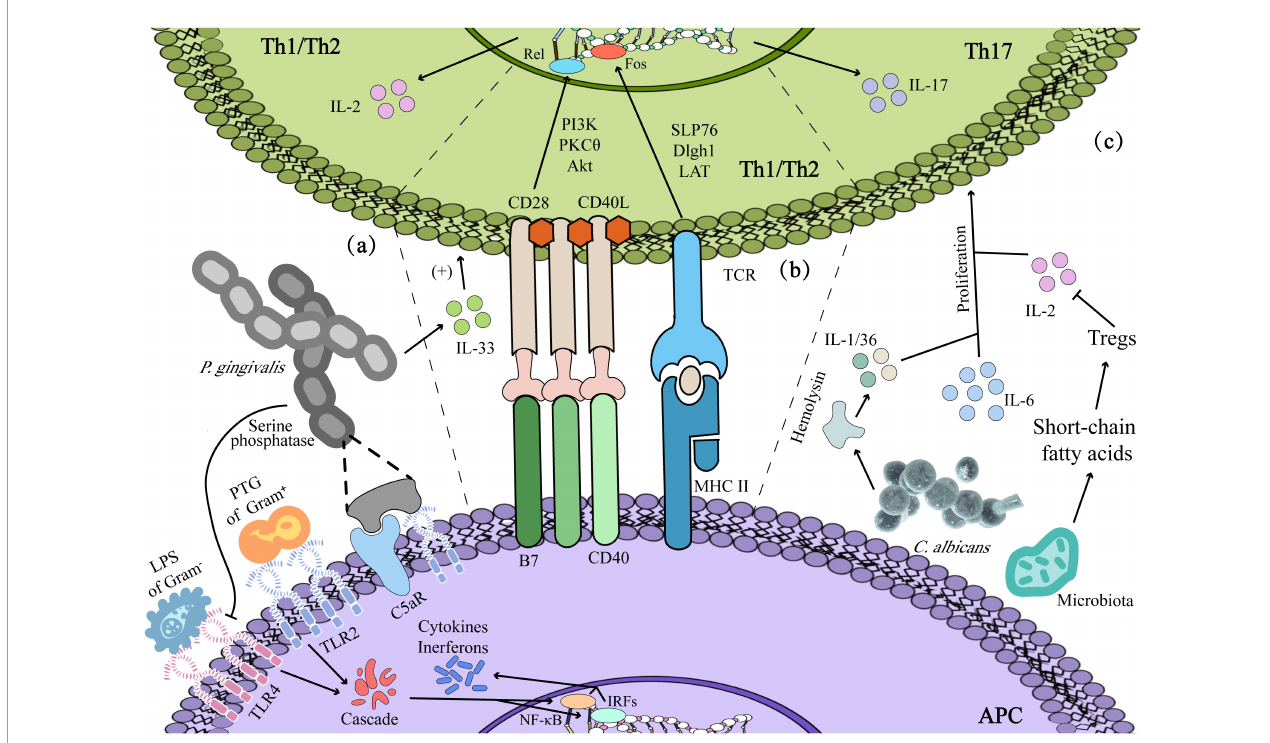
FIGURE3 Dysbiosis-induced immunoreaction: (a) innate immunity: lipopolysaccharide (LPS) and Peptidoglycan (PTG) contribute to the activation of immune and inflammatory responses in Th1/2. (b) Adaptive immunity: Porphyromonas gingivalis enhanced Th2 cytokine-mediated inflammatory immune response by prompting the secretion of IL-33 of epithelium, and antigen presentation by antigen–presenting cells (APCs) could activate Th1/2 by signal 1 and signal 2. (c) Candida albicans producing cytokines such as IL-1/IL-36 mediates the expression of IL-17 and the proliferation of Th17 cells, and short-chain fatty acids produced by microbiota facilitate the viability of Th17 with regulating the